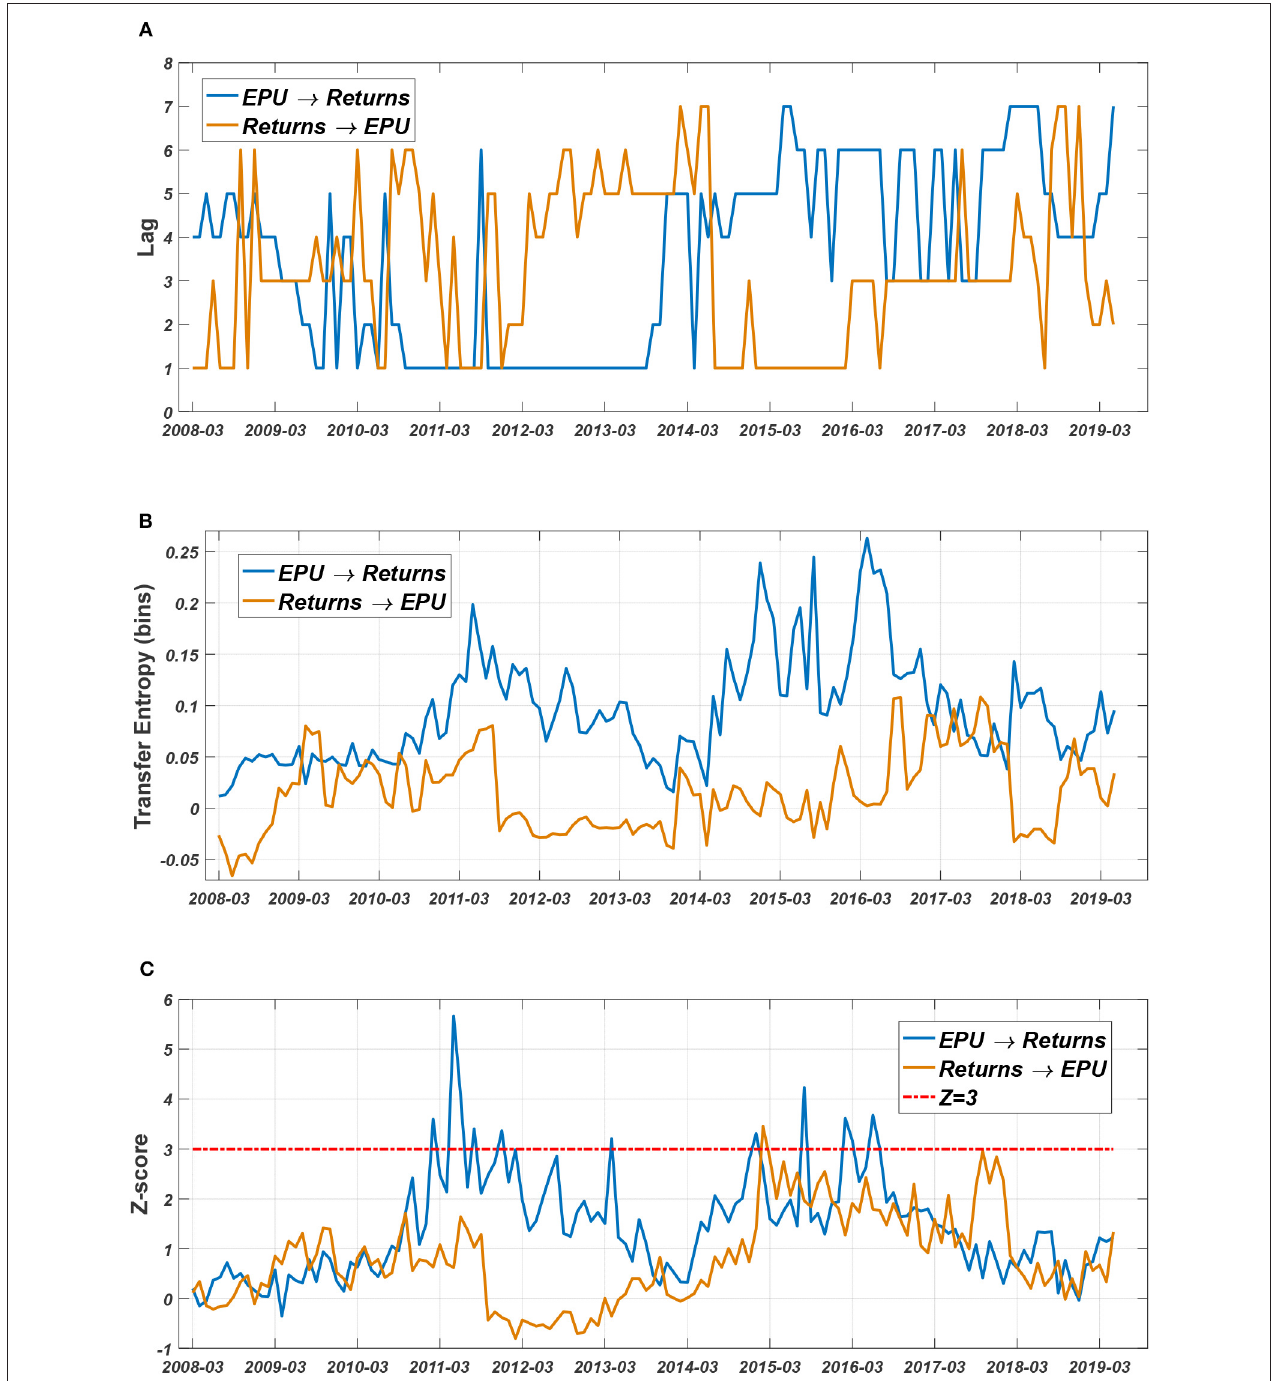
FIGURE 8 | Entropy between EPU and stock market. (A) Lag structure. (B) TE fluctuation. (C) Z